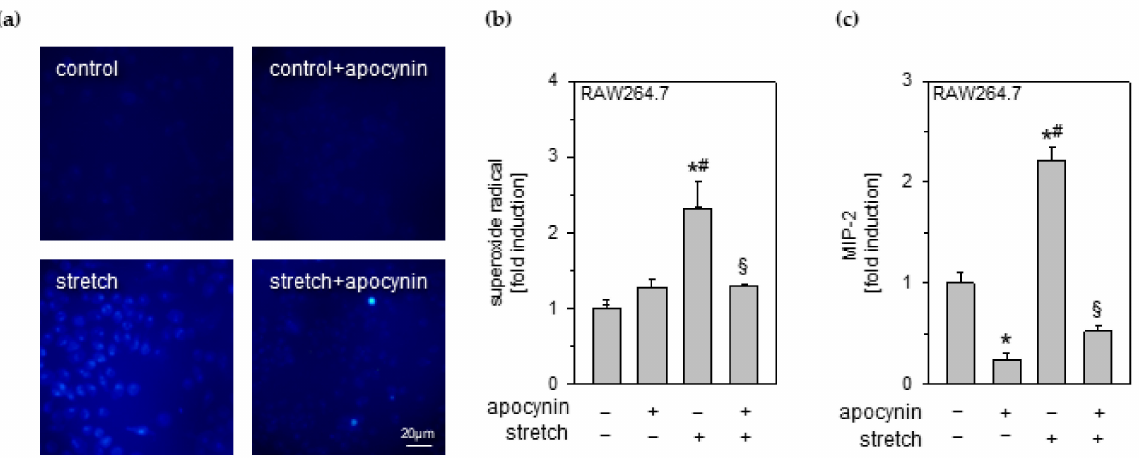
Figure 3. Effects of cyclic stretch and NADPH oxidase inhibition on ROS and inflammation on macrophages. RAW264.7 macrophage cells stretched and incubated with 2 mM apocynin as indicated. ( a ) Representative rainbow false-colored images of DHE staining for superoxide radicals and ( b ) the corresponding densitometric analysis. ( c ) The amount of MIP-2 in cell medium supernatant was determined by ELISA. Data represent means ± SEM for n = 3/group. Analysis of variance (Tukey’s post hoc test), * p < 0.05 vs. control; # p < 0.05 vs. control + apocynin; § p < 0.05 vs.